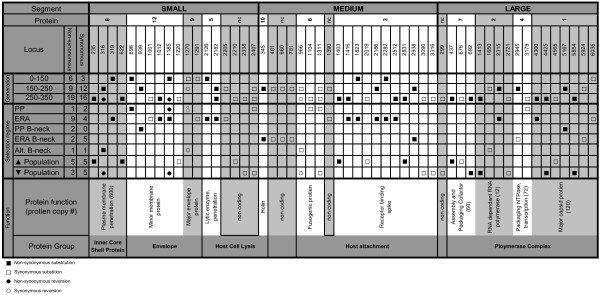
Molecular changes, in light of segment location, treatment regime and protein function